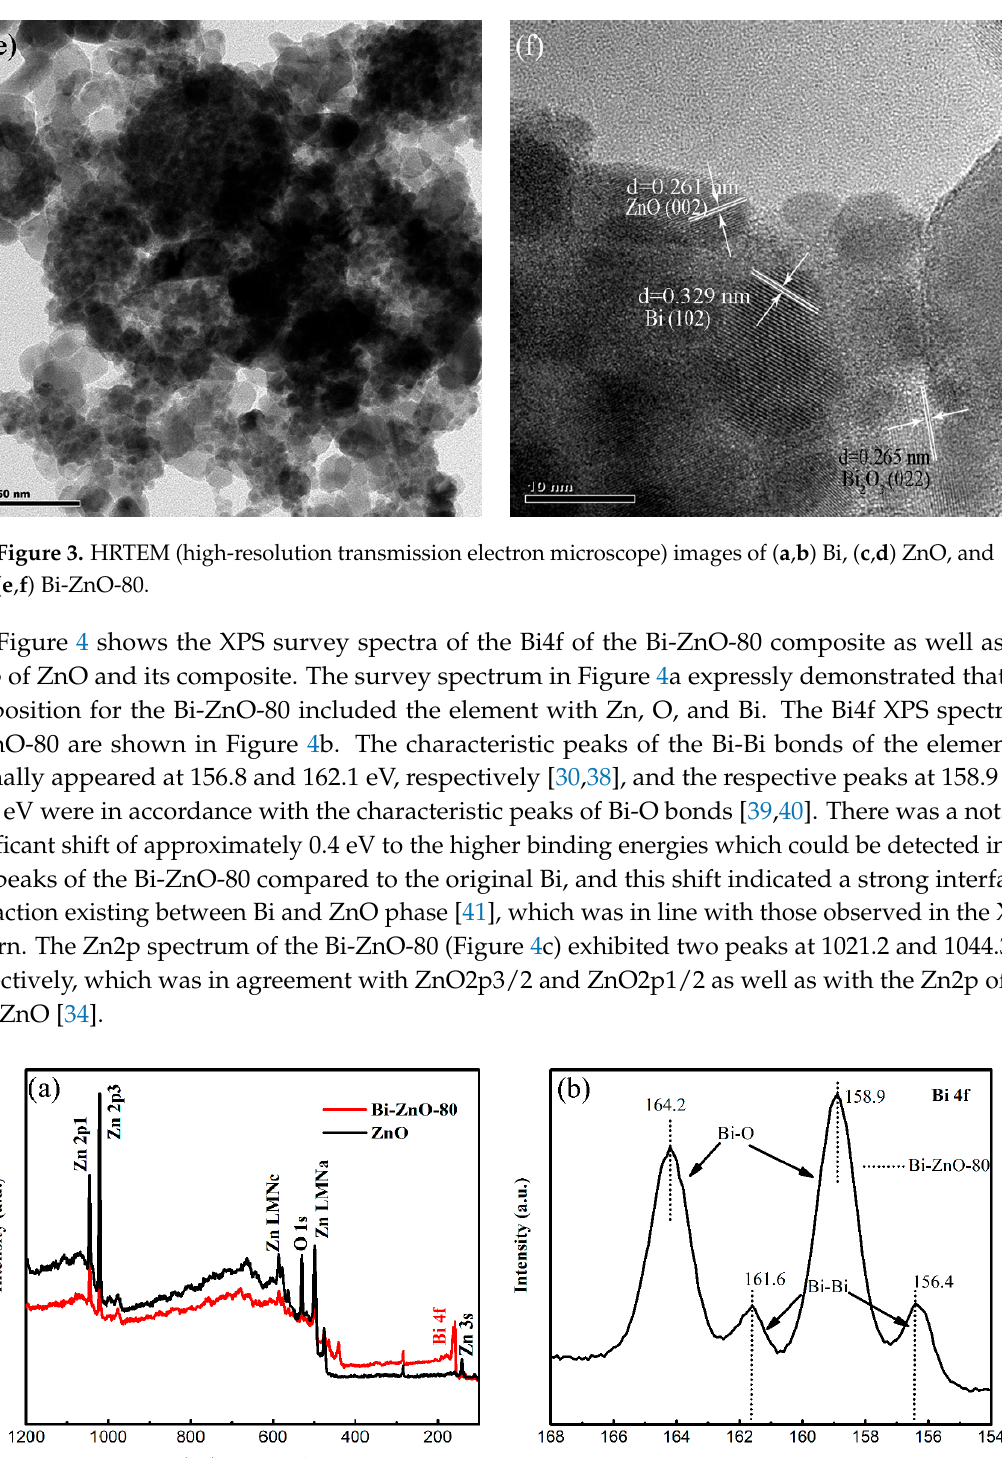
Figure 4. ( a ) XPS survey spectra, ( b ) Bi4f, and ( c ) Zn2p peaks of the Bi-ZnO-80 composite.